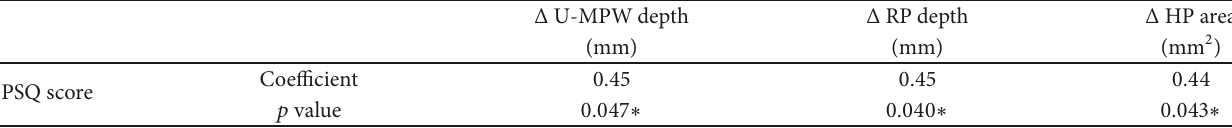
Table 4: Correlation analysis between changes in upper airway dimensions and PSQ